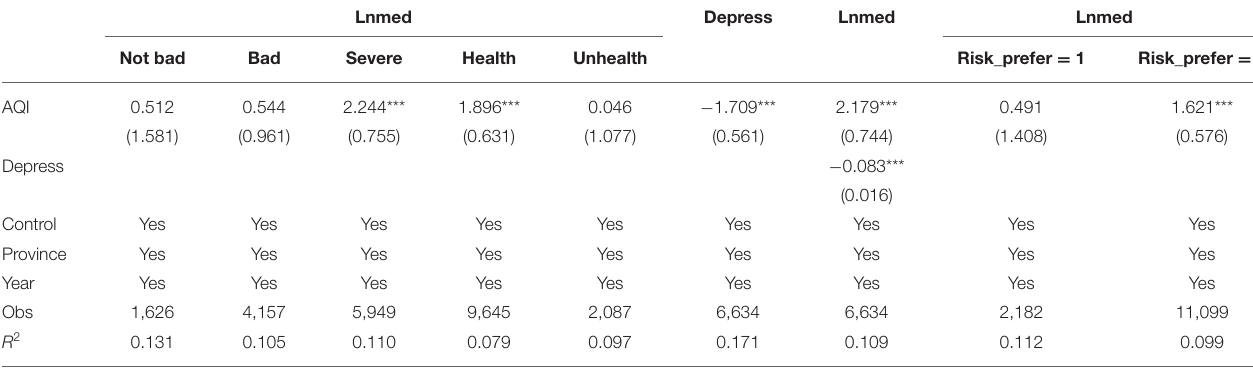
TABLE 5 | Impact of air pollution on household medical expenses: pollution awareness, health status, depression and risk